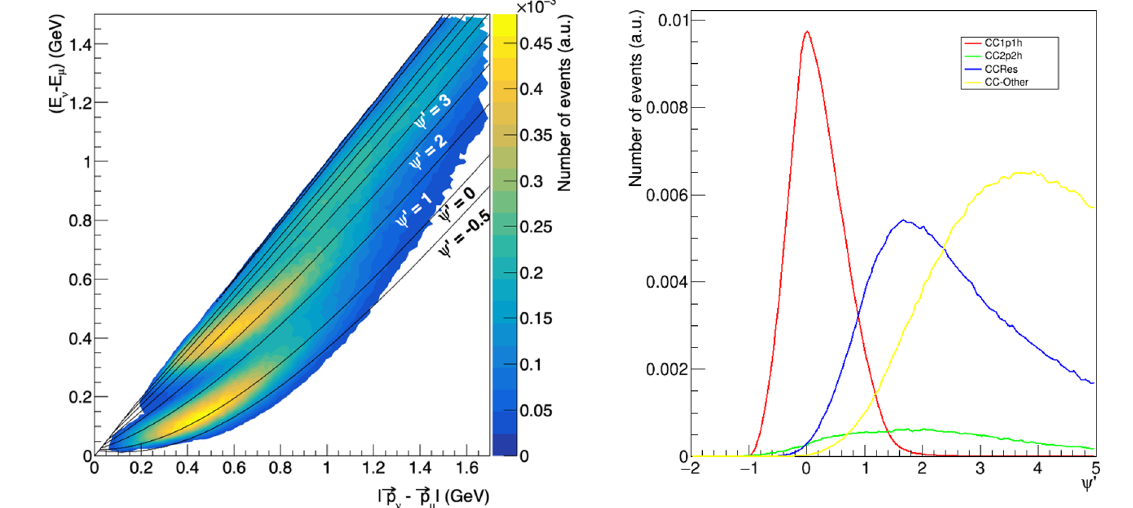
Figure 18 . Left: CC inclusive MINERvA [ | ~q | = | ~p ν − ~p µ | , q 0 = ( E ν − E µ ) ] 2D distribution predicted by the NEUT CC inclusive event generator. The black solid lines mark fix ψ 0 values across the ( q 0 , | ~q | ) -plane. Right: ψ 0 distribution of events obtained from the 2D one shown in the left-panel, and separated by the primary neutrino-nucleon interaction